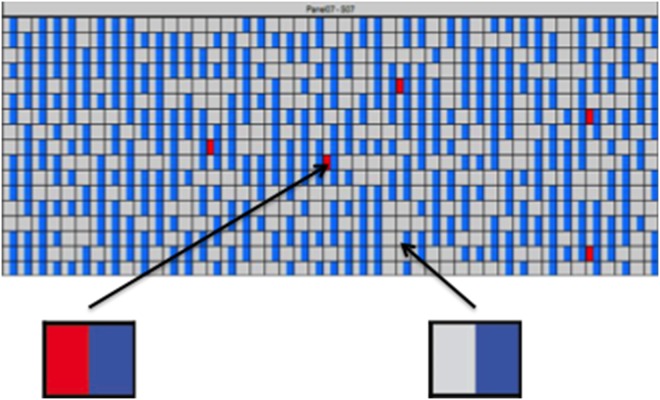
Determination of the detection limit of the D-PCR assay for T790M mutation.The assay panel included 765 chambers. A chamber harboring both red signal and blue signal represented T790M positive ones. Only blue signal in the chamber represented negative T790M mutation. This figure referred to the panel based status of T790M mutation when the mixed DNA (T790M mutant DNA fragments and internal control DNA fragments) with dilution concentration of 1∶3000.